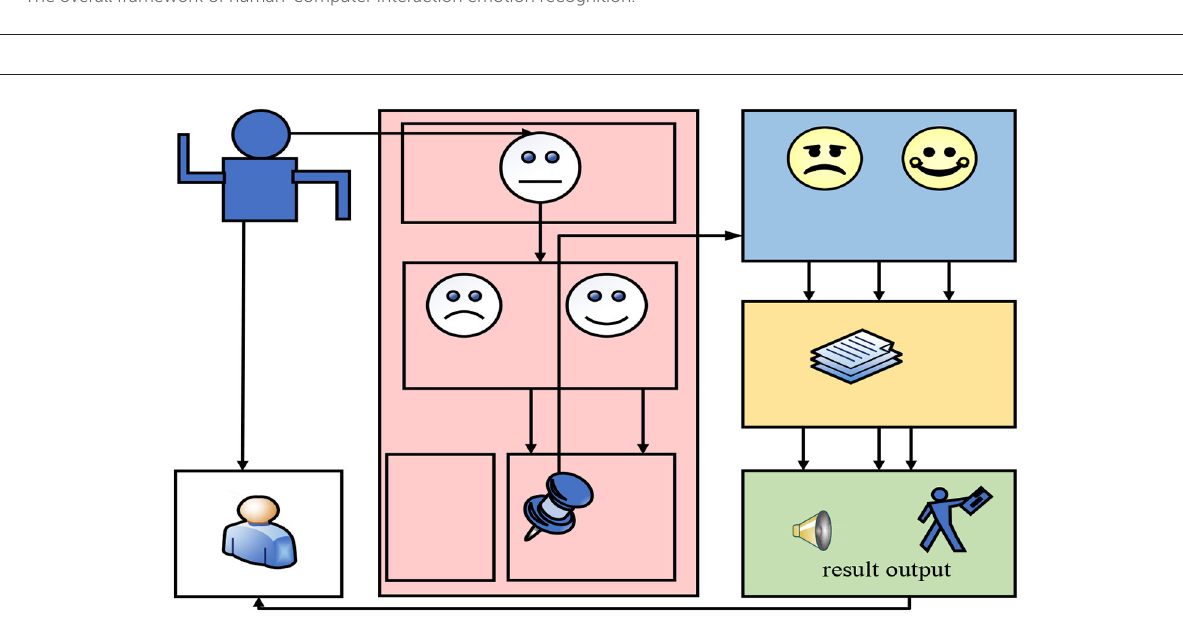
FIGURE2 Overall frame diagram of human-computer intelligent interaction